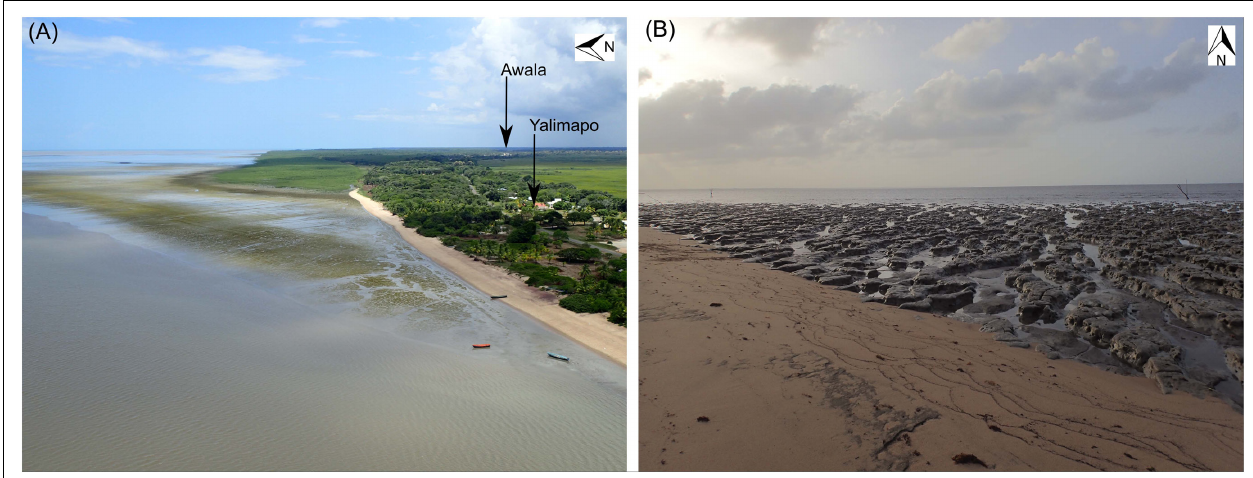
FIGURE 5 | Encroachment of a shore-attached mud bank on Yalimapo beach (see Figure 1B ) since 2014, resulting in increasing inland isolation of the eastern part of the beach and of the hitherto beach-front village of Awala (A) , and reworked shoreface mud in front of the beach (B) . The mud bank is progressively colonized by an advancing front of Avicennia germinans